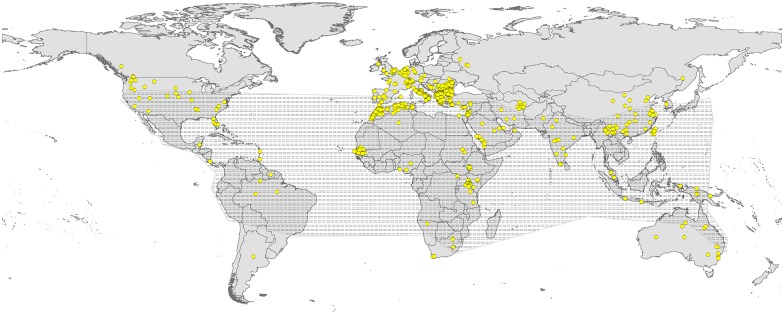
Summary of bluetongue virus occurrences (yellow points) available for model calibration worldwide.Dotted black shading represents the early belt of BTV occurrence.